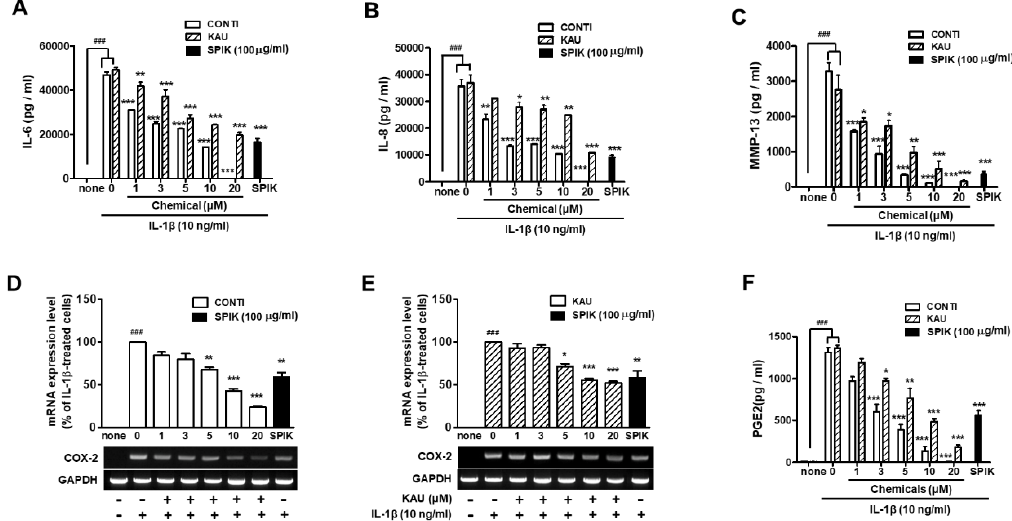
Figure 3. E ff ects of continentalic and kaurenoic acids on the IL-1 β -stimulated protein or mRNA expression levels of IL-6 ( A ), IL-8 ( B ), MMP-13 ( C ) and COX-2 ( D , continentalic acid; E , kaurenoic acid), and PGE2 production ( F ) in human OA chondrocytes. The 50% ethanolic extract of Manchurian spikenard (100 µ g / mL) was used as a control (black bar in each graph). SPIK, Manchurian spikenard extract; CONTI, continentalic acid; KAU, kaurenoic acid; MMP, matrix metalloproteinase; COX, cyclooxygenase; PGE2, prostaglandin E2; GAPDH, glyceraldehyde 3-phosphate dehydrogenase. ### p < 0.001 vs. non-treated naïve cells (none); * p < 0.01, ** p < 0.005 and *** p < 0.001 vs. the IL-1 β -treated group without treatments.